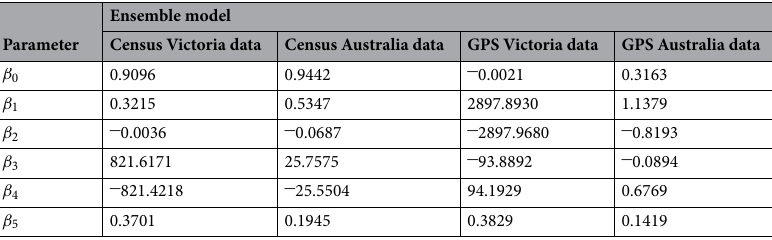
Table 1. Ensemble model weights. Parameter description: β 0 model intercept, β 1 gravity model weight, β 2 gravity with distance model weight, β 3 radiation model weight, β 4 radiation with selection model weight and β 5 intervening opportunities model